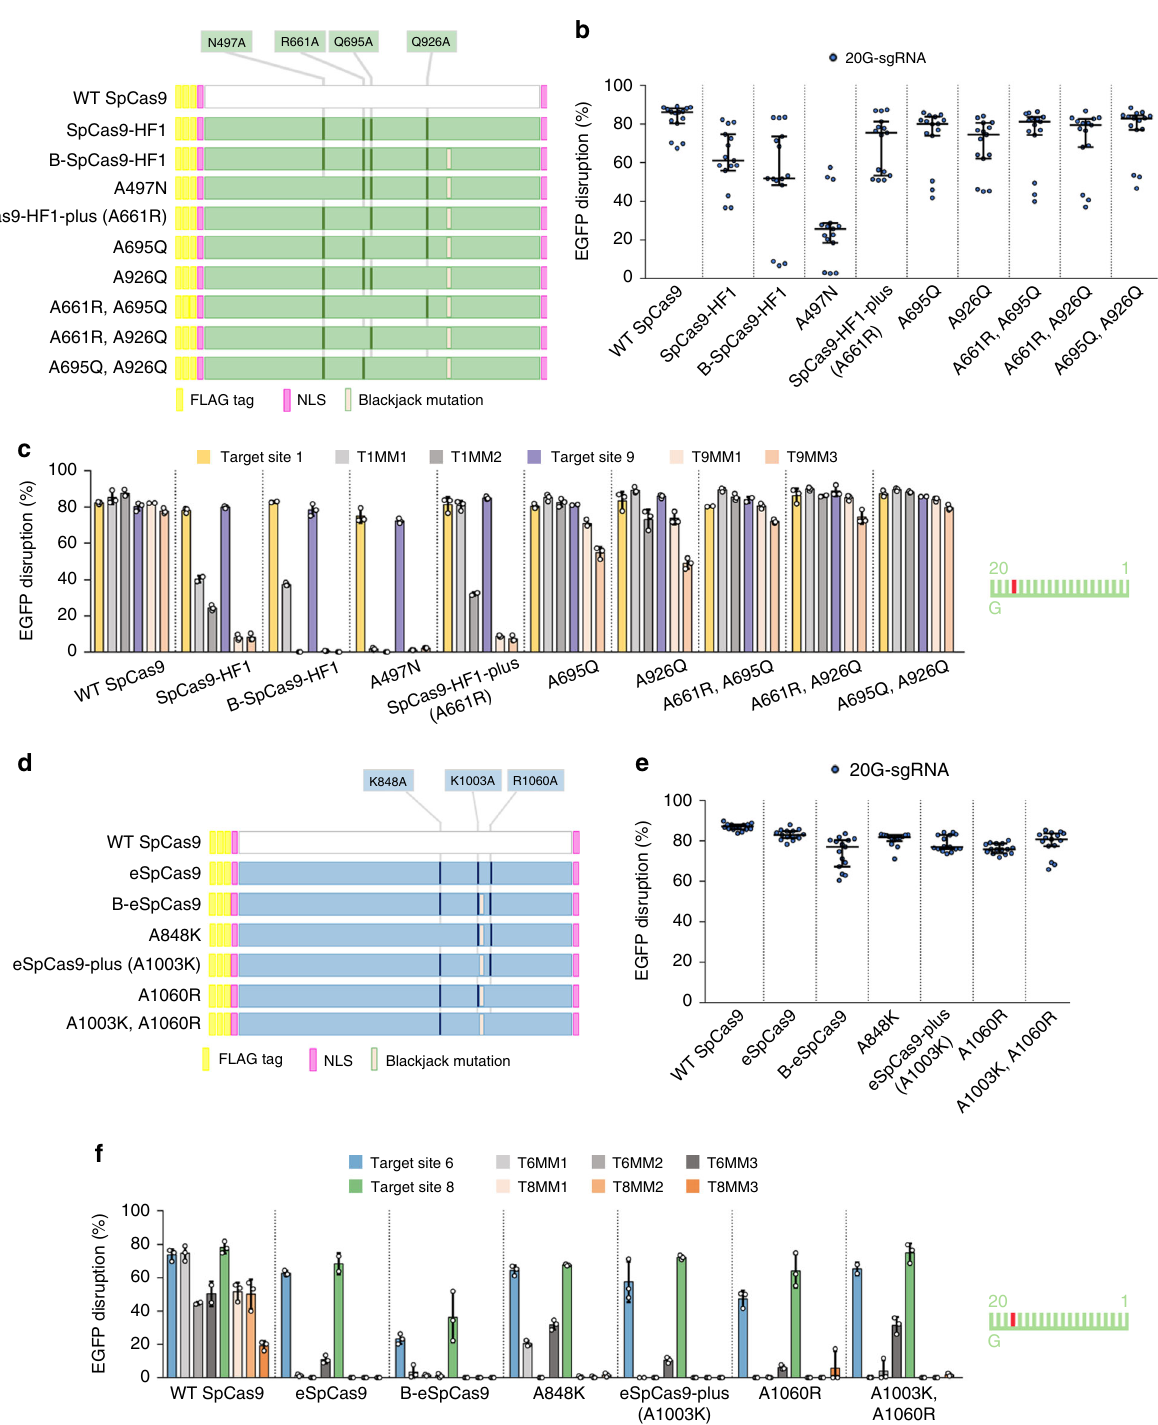
Fig. 4 Restoring mutations to WT amino acids lowers the (on-)target-selectivity and fi delity of B-eSpCas9 and B-SpCas9-HF1. a , d Schematic representation of the mutations in each variant examined. b , e On-target activities using 20G-sgRNAs measured on fi ve target sites ( n = 3 biologically independent samples [overlaid as blue circles]), employing the EGFP-disruption assay, median and interquartile range are shown. c , f Mismatch screen results from EGFP-disruption assay. Target sites and matching (e.g., T1, T6) or mismatching sgRNAs (e.g., T1MM1, T6MM1) are the same as in Supplementary Fig. 3. Spacers are schematically depicted beside the charts as combs: green color teeth indicate matching-, while a red color tooth indicates the presence of a mismatching nucleotide (not necessarily the exact position) within the spacer; numbering of the tooth positions corresponds to the distance of the nucleotide from the PAM; the starting 20th nucleotide of the spacer is indicated by an uppercase letter. Means are shown, error bars represent the standard deviation (s.d.) for n = 3 biologically independent samples (overlaid as white